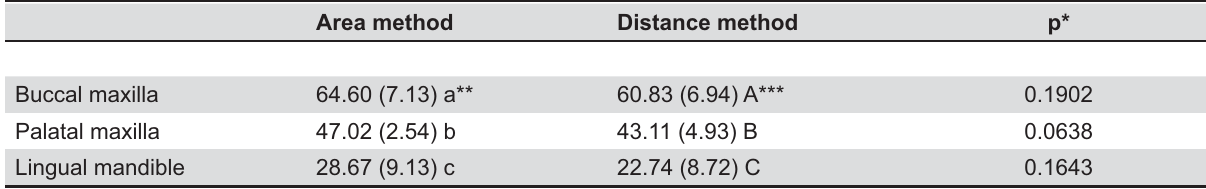
Table 1- Mean and standard deviation of alveolar bone loss (%) at the evaluation location